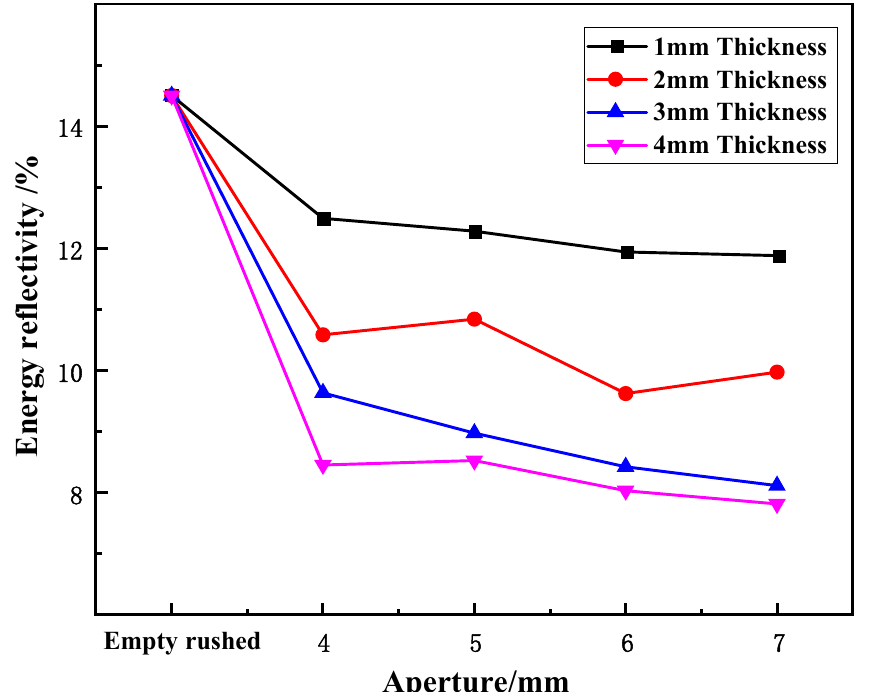
Figure 9. Variation trend of energy reflectance of wave-absorbing metal plate with aperture size.